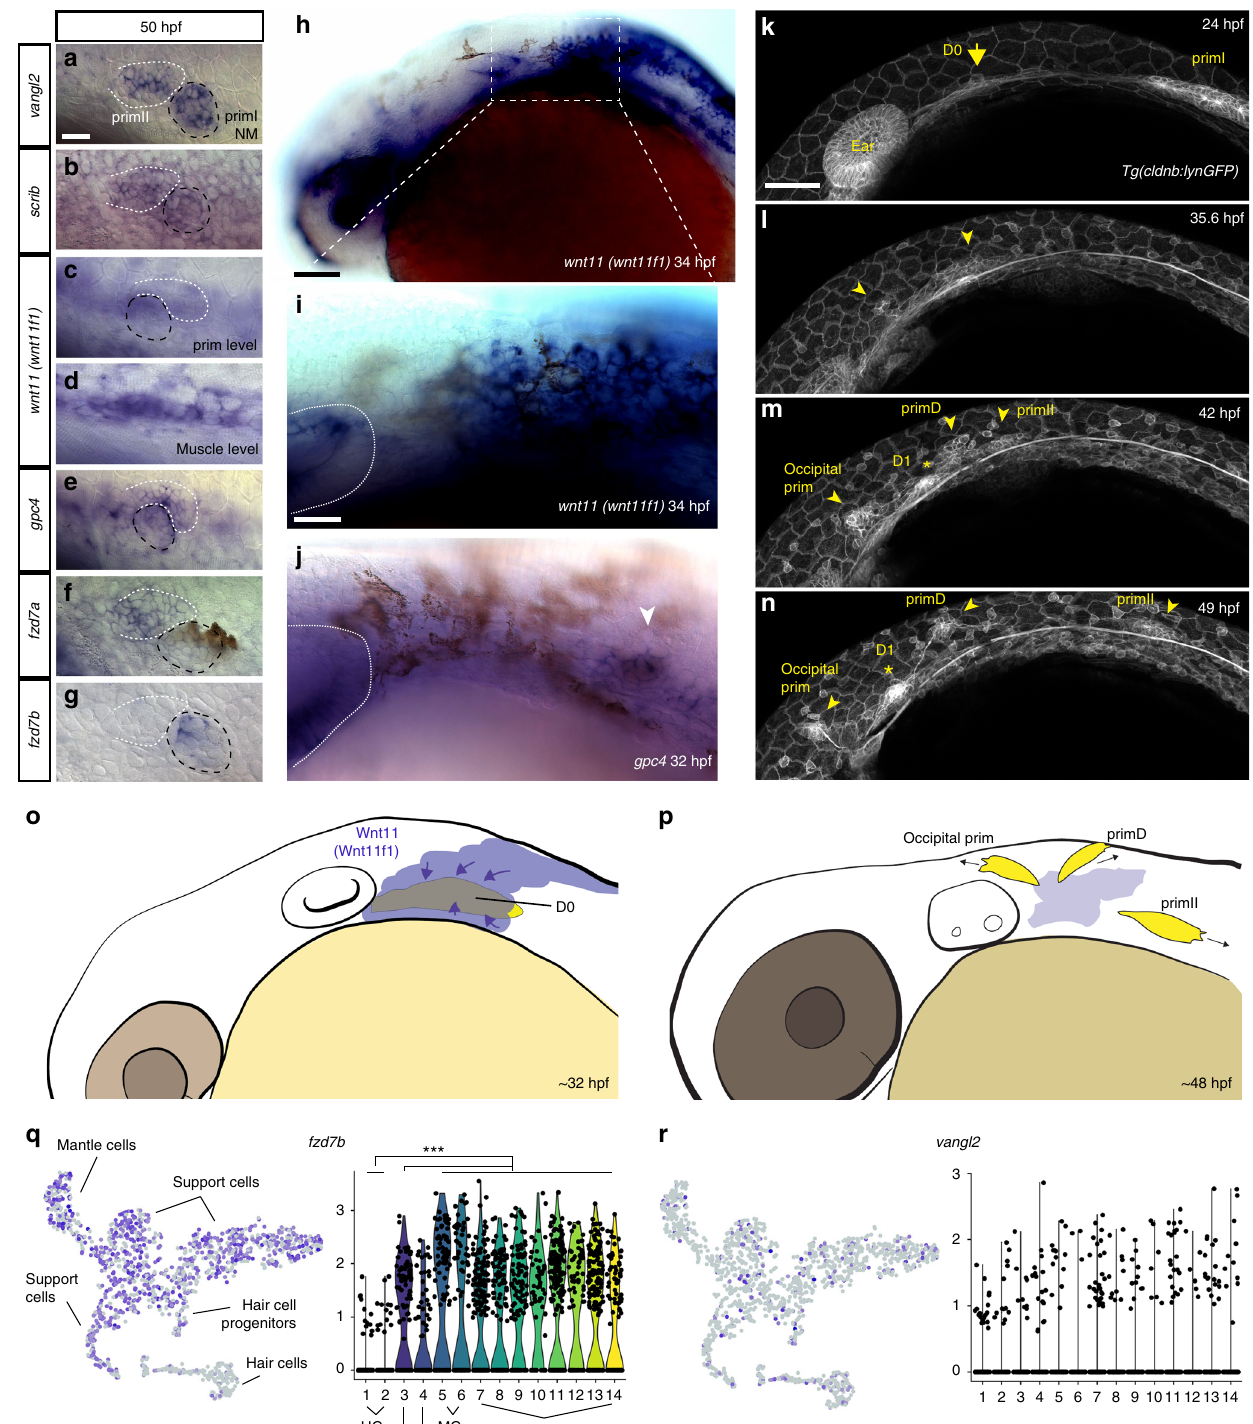
How are the different orientations in primI and primII-derived neuromasts achieved? PCP pathway mutations disrupt hair cell orientations in all neuromasts. Thus, the mechanisms that control differential A-P and D-V orientations in primI and primII- derived neuromasts are either acting upstream or in parallel to PCP signaling. Lopez-Schier et al. 37 proposed that the direction of the migrating primordia or the recently deposited neuromasts determines the axis of polarity. Neuromasts deposited by primII migrate ventrally after deposition 32,73 , which has been correlated